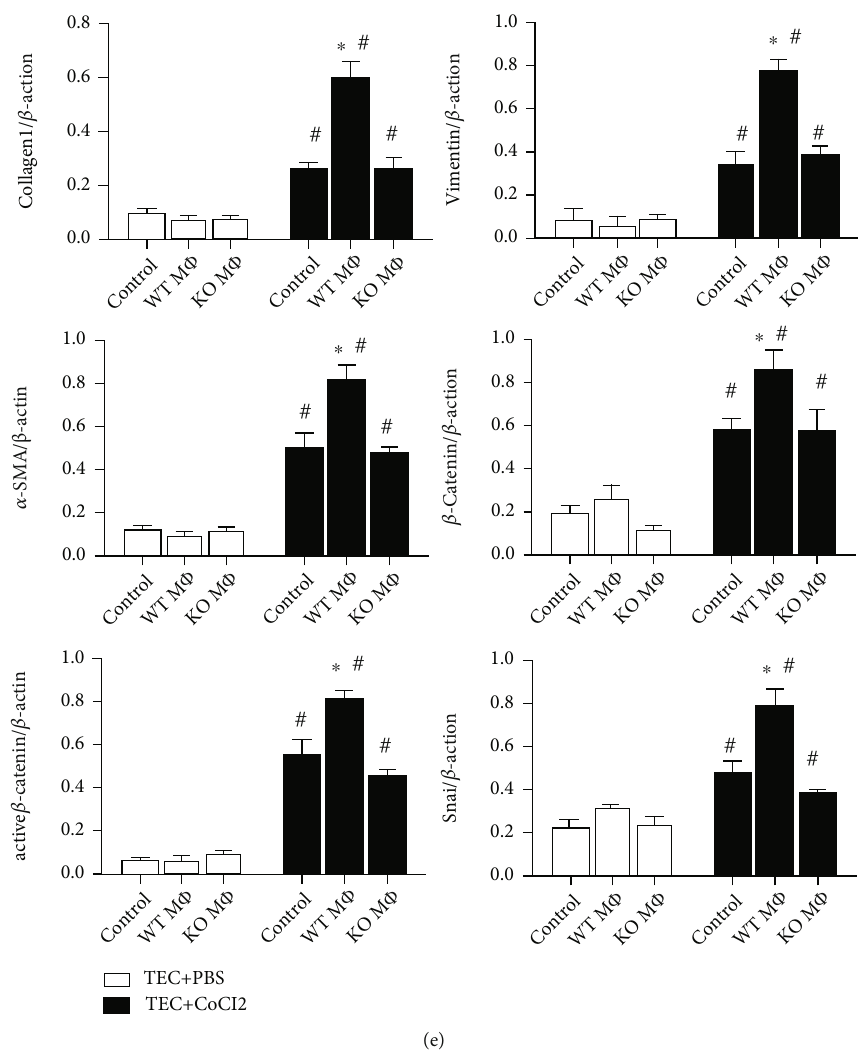
Figure 7: Primary TECs treated with CoCl to imitate IRI in vitro and then cocultured with WT M Φ s or KO M Φ s. Then, the fi brosis 2 markers and Wnt/ β -catenin pathway were investigated. (a) Expression of α -SMA by immunohistochemistry in control TECs (top) and IRI TECs (bottom) cocultured with PBS (left), WT M Φ s (middle), and KO M Φ s (right). Representative images of α -SMA staining show distribution in the cytoplasm of TECs that underwent fi brosis. Magni fi cation, × 100. (b) Immunohistochemistry images were measured by ImageJ, and data are presented as the mean ± s : d . ∗ P < 0 : 05 versus control and coculture with KO M Φ s; # P < 0 : 05 versus TECs without IRI; n = 3 . (c) Protein levels of α -SMA, vimentin, and collagen I as fi brosis markers were measured by Western blotting. (d) Protein levels of β -catenin, active β -catenin, and Snai1 as signals of the Wnt/ β -catenin pathway were measured by Western blotting. (e) Quanti fi cation of Western blot analyses for the proteins mentioned above; the data showed that all fi brosis markers were increased signi fi cantly accompanied by Wnt/ β -catenin pathway activation in IRI TECs cocultured with KO M Φ s compared with the WT M Φ coculture group and control group, while the expression of the proteins showed no signi fi cant di ff erence in TECs without IRI. Data are presented as the mean ± s : d . ∗ P < 0 : 05 versus control or coculture with KO M Φ s; # P < 0 : 05 versus TECs without IRI; n = 3 , one-way ANOVA followed by the Student-Newman-Keuls